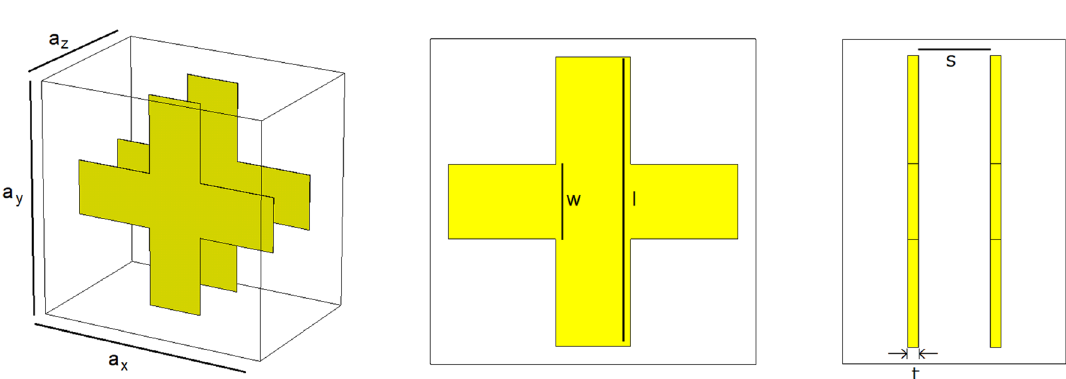
Figure 7. Paul et al.’s bulk metamaterial. Dimensions are as follows: a x = a y = 90 μm, a z = 62 μm , l p = 81 μm, w = 21 μm, s = 9.5 μm and t = 0.2 μm [Reprinted/Adapted] with permission from 27 © The Optical